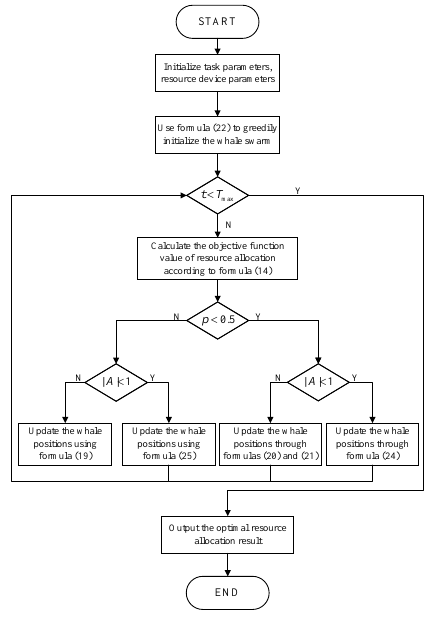
Figure 3. IPWOA flow